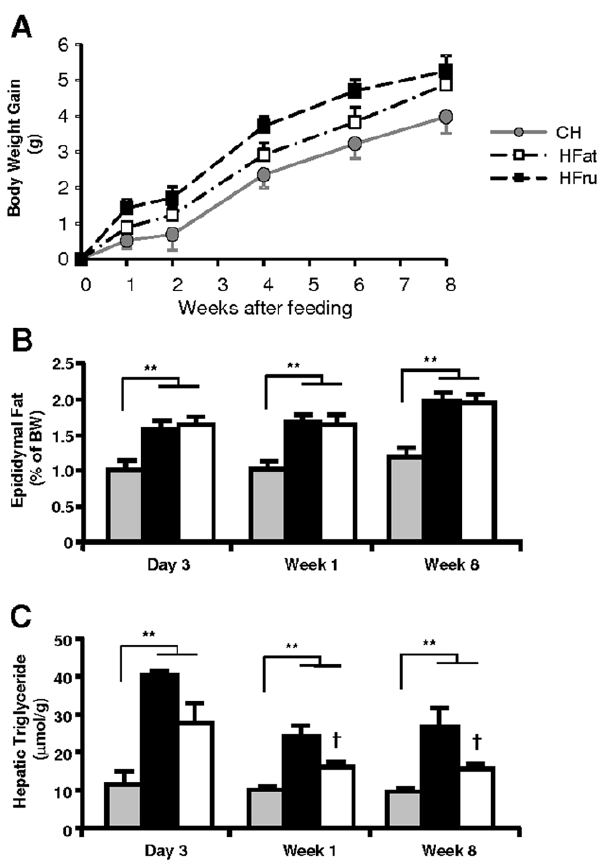
Figure 1. Effects on HFru and HFat feeding on weight gain, adiposity and liver triglyceride. Male C57BL/6J mice (13–16 weeks old) were fed a high-fructose (HFru) or a high-fat (HFat) diet ad libitum as compared to a standard laboratory chow diet (CH). The body weight was similar among the three groups at the start of the feeding intervention (23.6 6 0.3, 23.4 6 0.5 and 23.7 6 0.5 g). ( A ) Body weight gain over the baseline. ( B ) Weight of epididymal fat depots. ( C ) Liver triglyceride content. Liver samples were freeze-clamped for the measurement of hepatic triglyceride content after 5–7 hour of fasting. Data are mean 6 SE of 8–13 mice per group. ** p , 0.01; { p , 0.05, {{ p , 0.01 vs HFru.